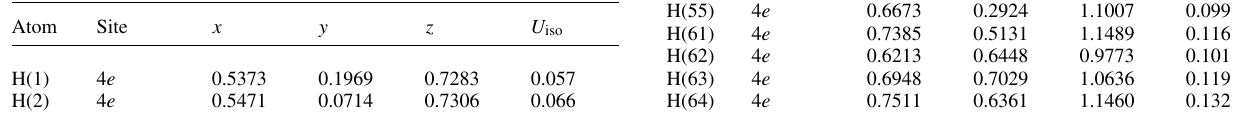
Table 2. Atomic coordinates and displacement parameters (in Å 2 ) .